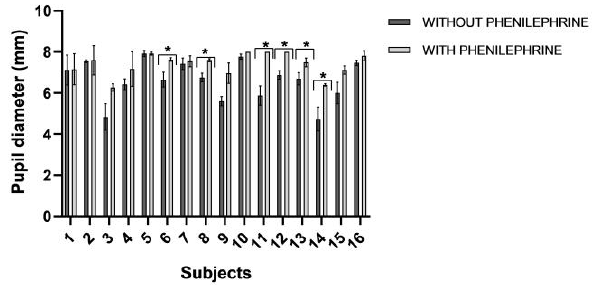
Figure 1. Representation of the pupil diameter in the different subjects measured, with and without the effect of PHCl. Error bars represent the standard deviation (SD). * Simple paired t -tests, statistically significant (𝑝 − value < 0.05)